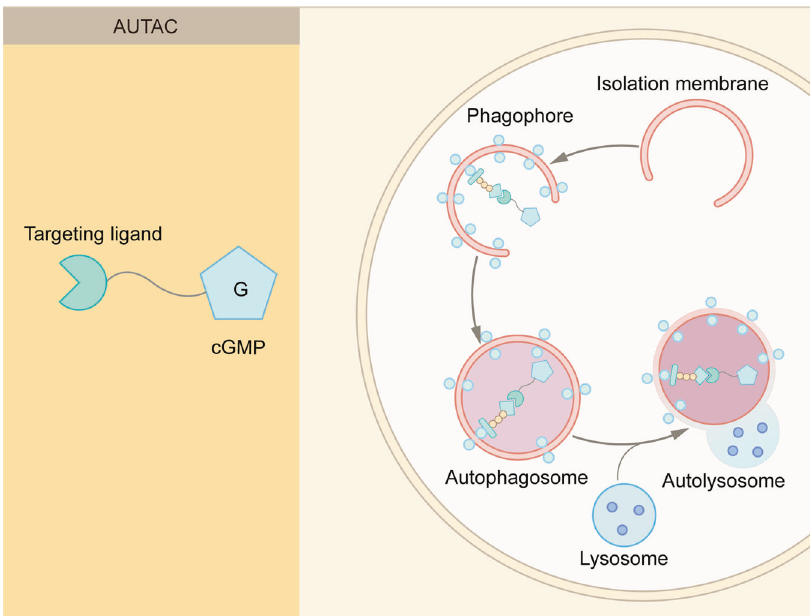
Fig. 10 Schematic representation of AUTAC. AUTAC molecules consist of a POI-targeting warhead, a linker, and a cGMP-based degradation tag. The degradation tag recruits autophagosomes to degrade cytoplasmic proteins and cellular